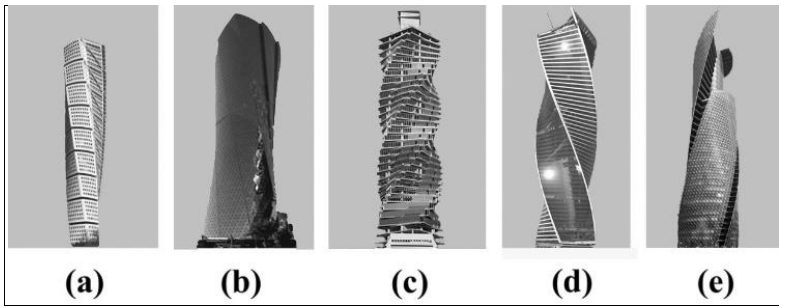
Figure 3. Twister and Tordos types of high-rise building: ( a ) Turning Torso (Malmö, mega core system), ( b ) Al Bidda Tower (Doha, wall frame system), ( c ) Revolution Tower (Panama City, core system), ( d ) Evolution Tower (Moscow, core system)) and ( e ) Mode Gakuen Spiral Towers (Nagoya, tube system), figure by